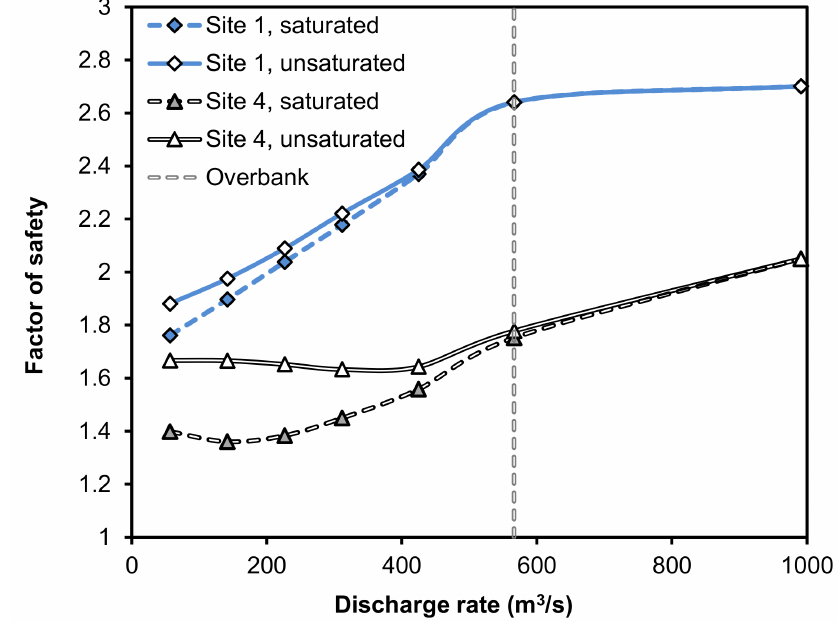
Figure 11. Comparison of saturated and unsaturated soil conditions under steady-state